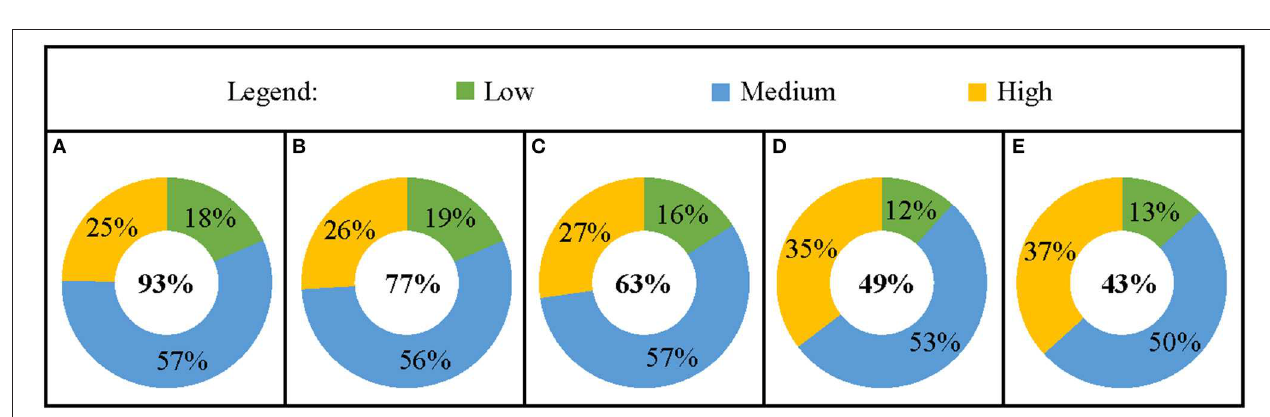
( p = 0.0002). Specifically, a greater number of organic